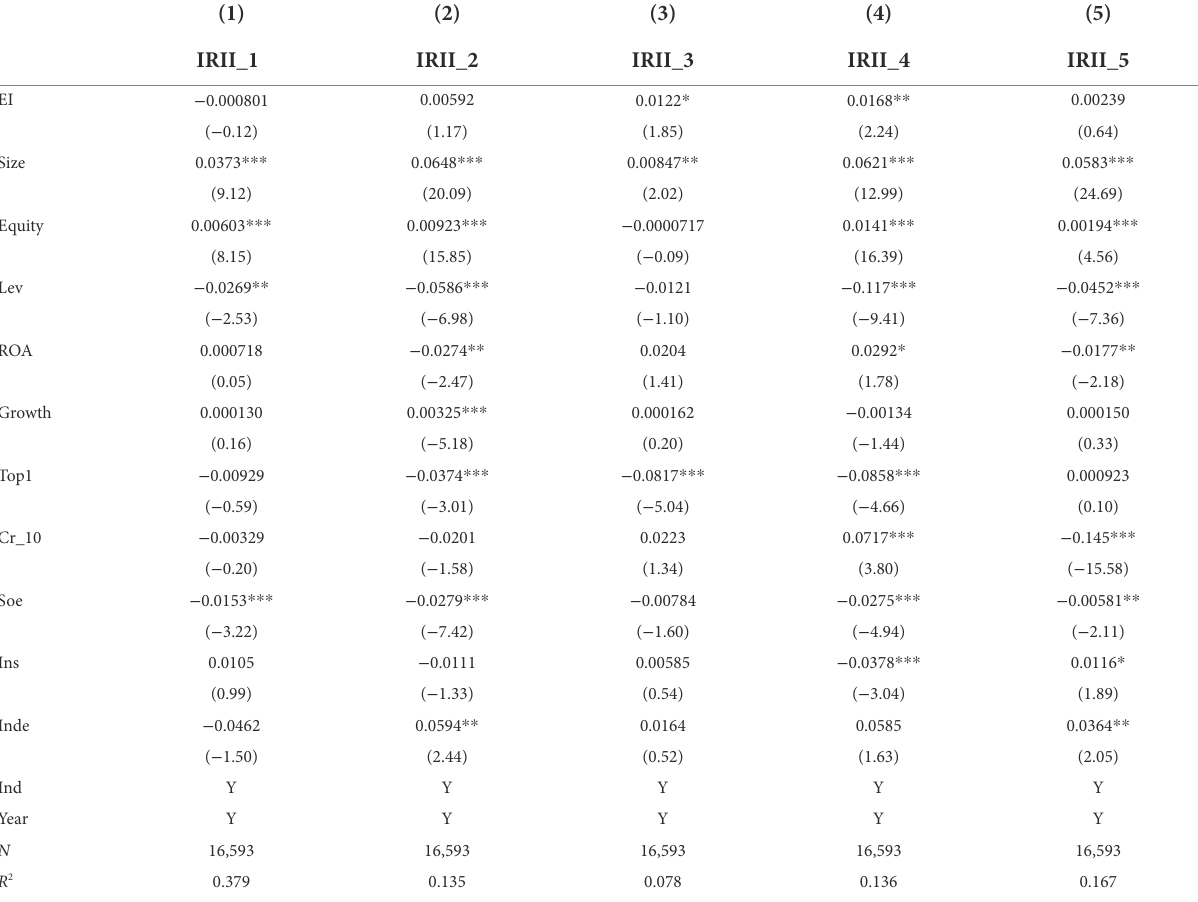
TABLE 8 The impact of EI on each sub-index of